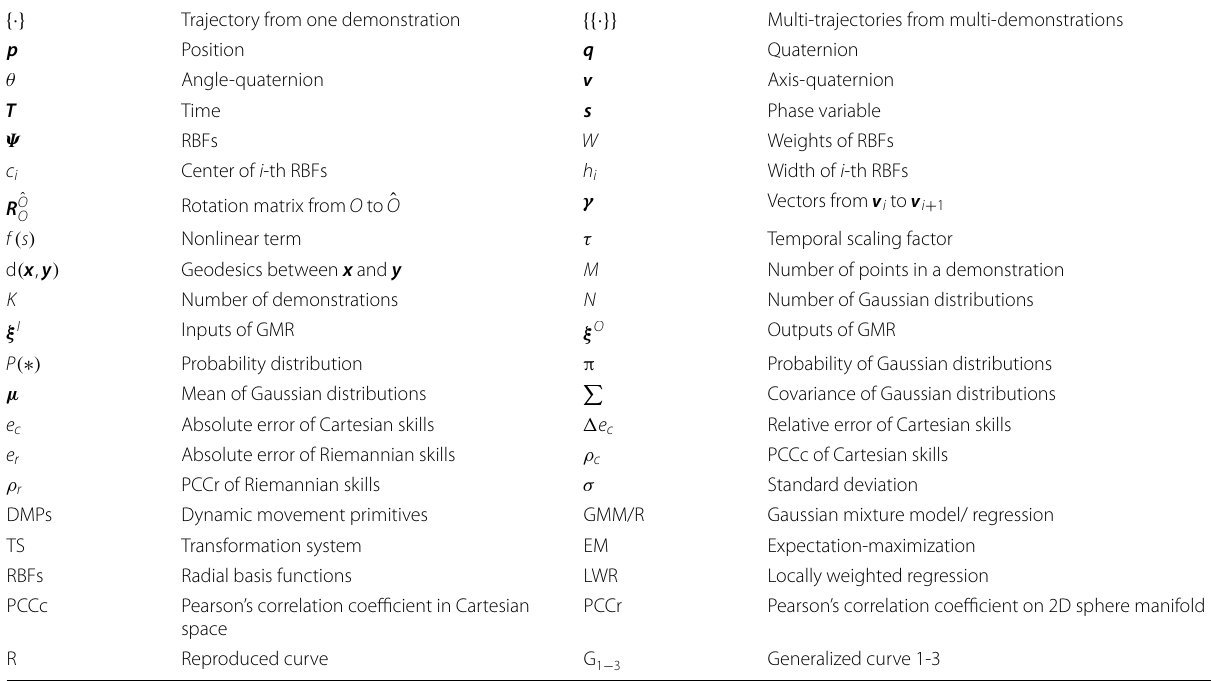
Table 1 Description of key notations and